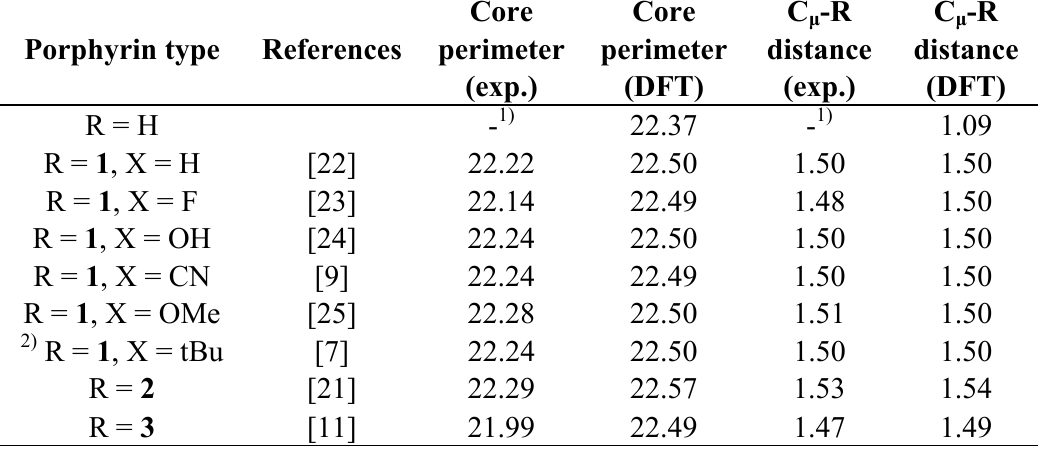
Table 2. Core perimeter and average C zinc porphyrins: Experimental (exp.) and DFT-derived results (all values in Å); porphyrin structures according to Figure 1; references to literature apply exclusively to experimental